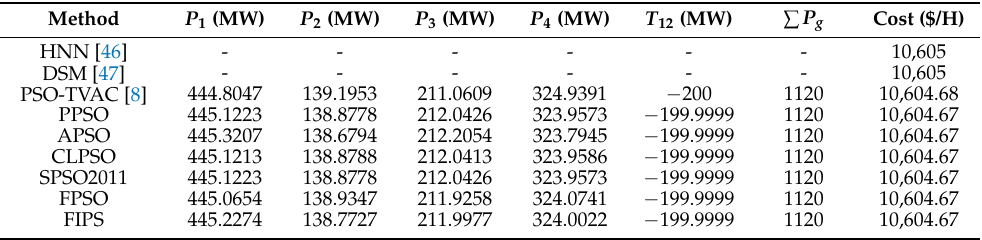
Table 1. Comparison of the best solutions obtained for the small-scale test